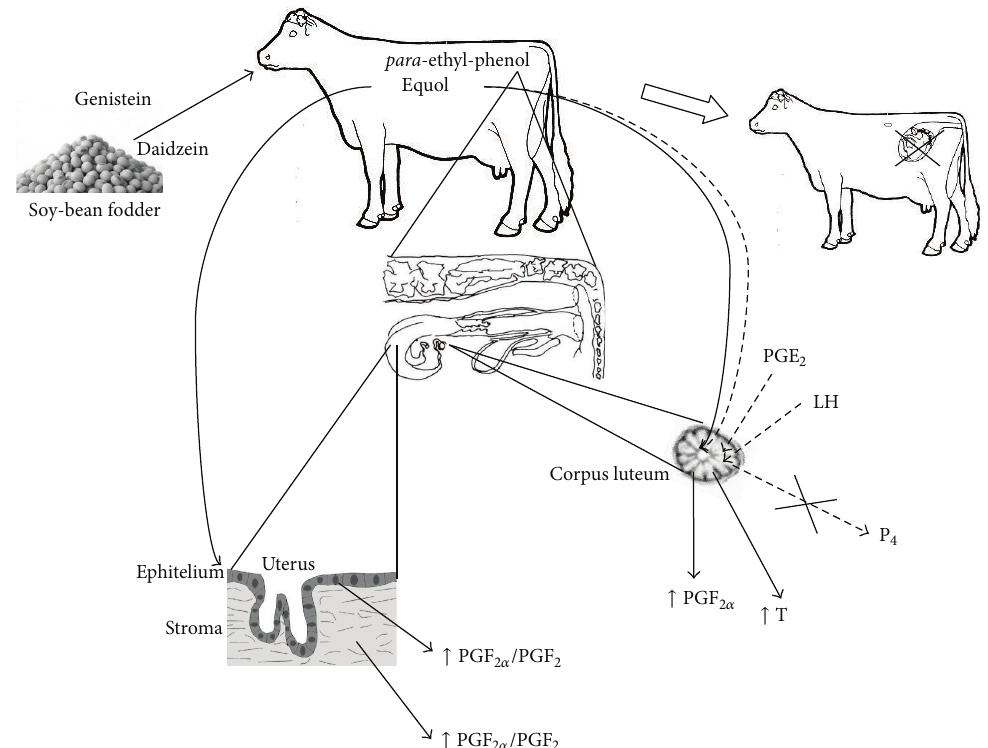
Figure 6: Possible influence of phytoestrogen action in the cow (the abbreviations on the figure stand for: LH—luteinizing hormone; P 4 — progesterone; PGE 2 —prostaglandin E 2 ; PGF 2𝛼 —prostaglandin F 2𝛼 ;